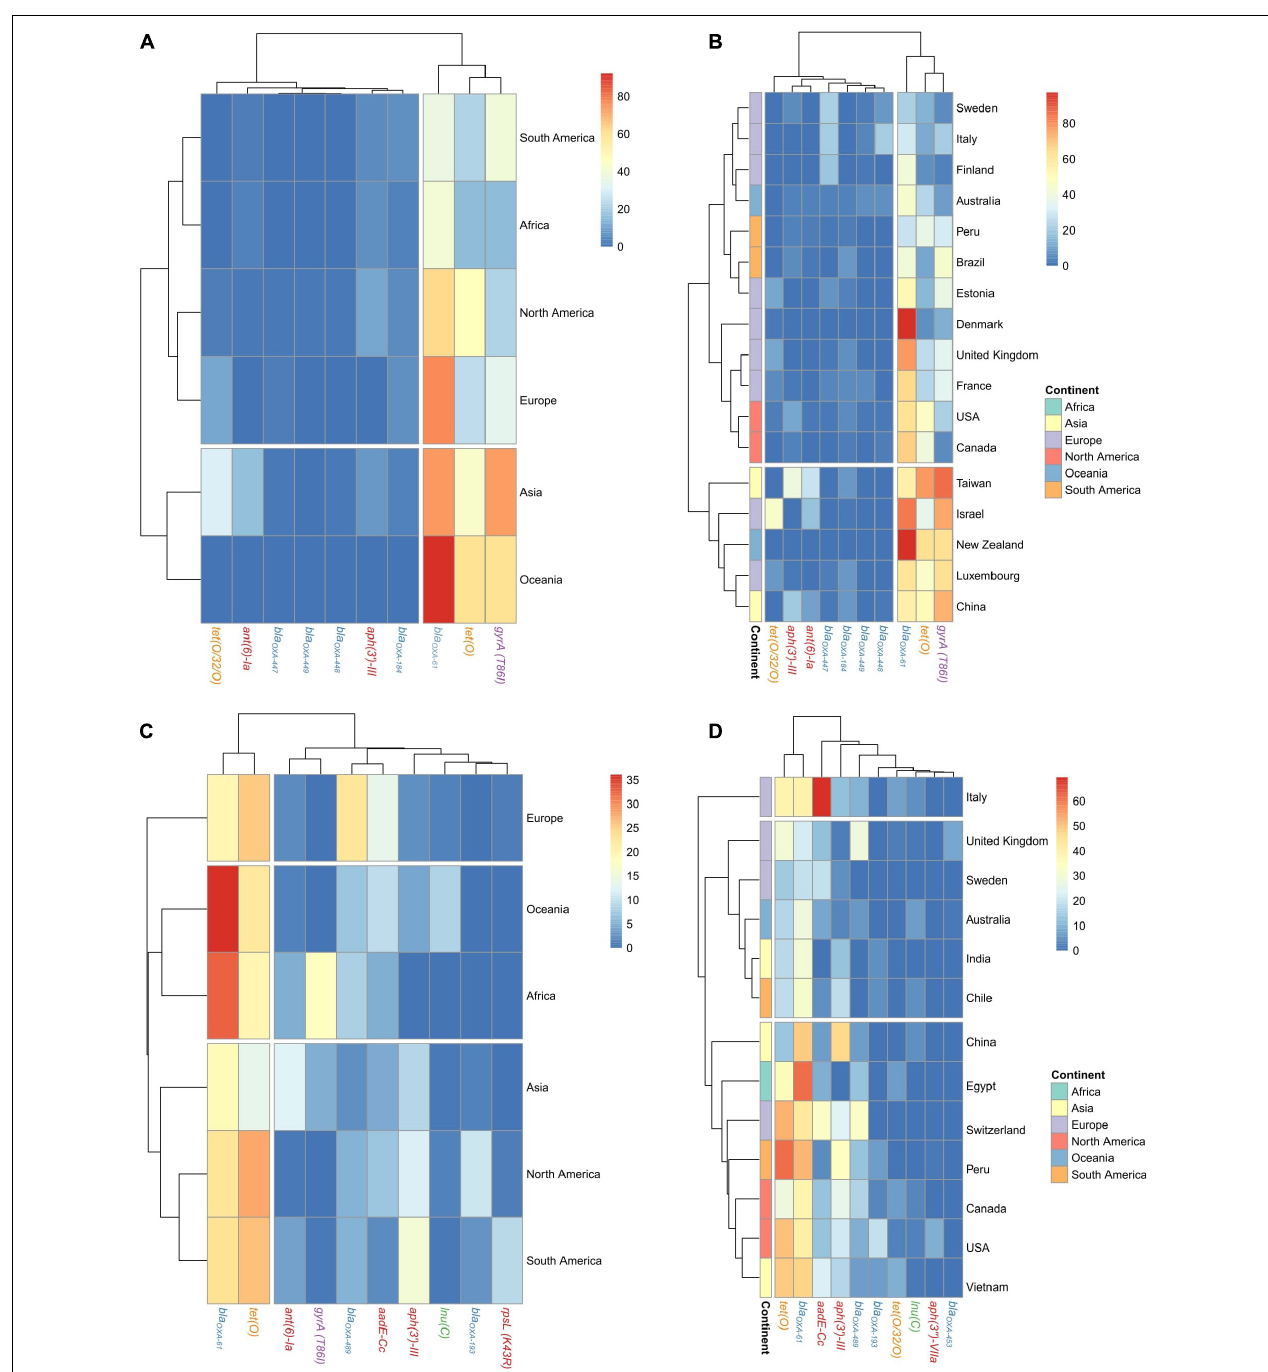
FIGURE 3 | Geographical distribution of AR genes and SNPs on C. jejuni and C. coli genomes. Heatmap plots showing the distribution of the main AR genes and SNPs on C. jejuni genomes among (A) continents and (B) countries and on C. coli genomes among (C) continents and (D) countries. Countries with less than 20 genomes were discarded for this analysis. Gene names are colored according to the corresponding antimicrobial family (blue: beta-lactams, orange: tetracyclines, red: aminoglycosides, purple: quinolones, and green: